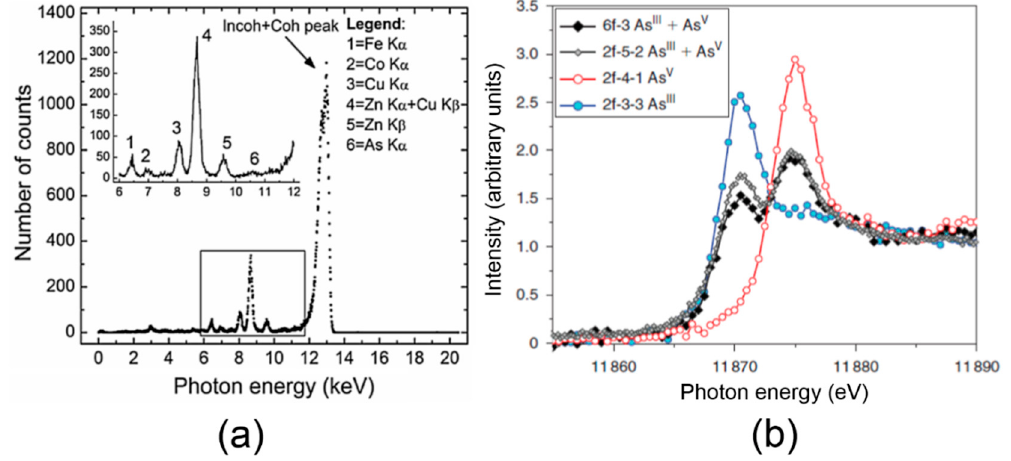
Figure 3. ( a ) XRF spectrum obtained from a 260-µm thick human fingernail cross section following a 2-s irradiation by a 13.0 keV monoenergetic X-ray beam at the Hard X-ray Micro-Analysis (HXMA) beamline from the Canadian Light Source (CLS) synchrotron. ( b ) X-ray absorption spectroscopy (XAS) spectra of As in four different human fingernail cross sections highlighting the pure and mixed As oxidation states. The red data points correspond to a high As concentration area in the same fingernail sample as the X-ray fluorescence (XRF) spectrum shown in plot ( a ). XAS spectra were acquired at the CLS and the Stanford Synchrotron Radiation Lightsource (SSRL) synchrotrons.